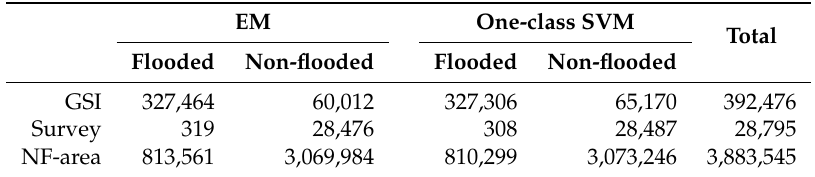
Table 1. Prediction of flooded and non-flooded areas at the areas depicted by GSI, the field survey at the agricultural targets, and the